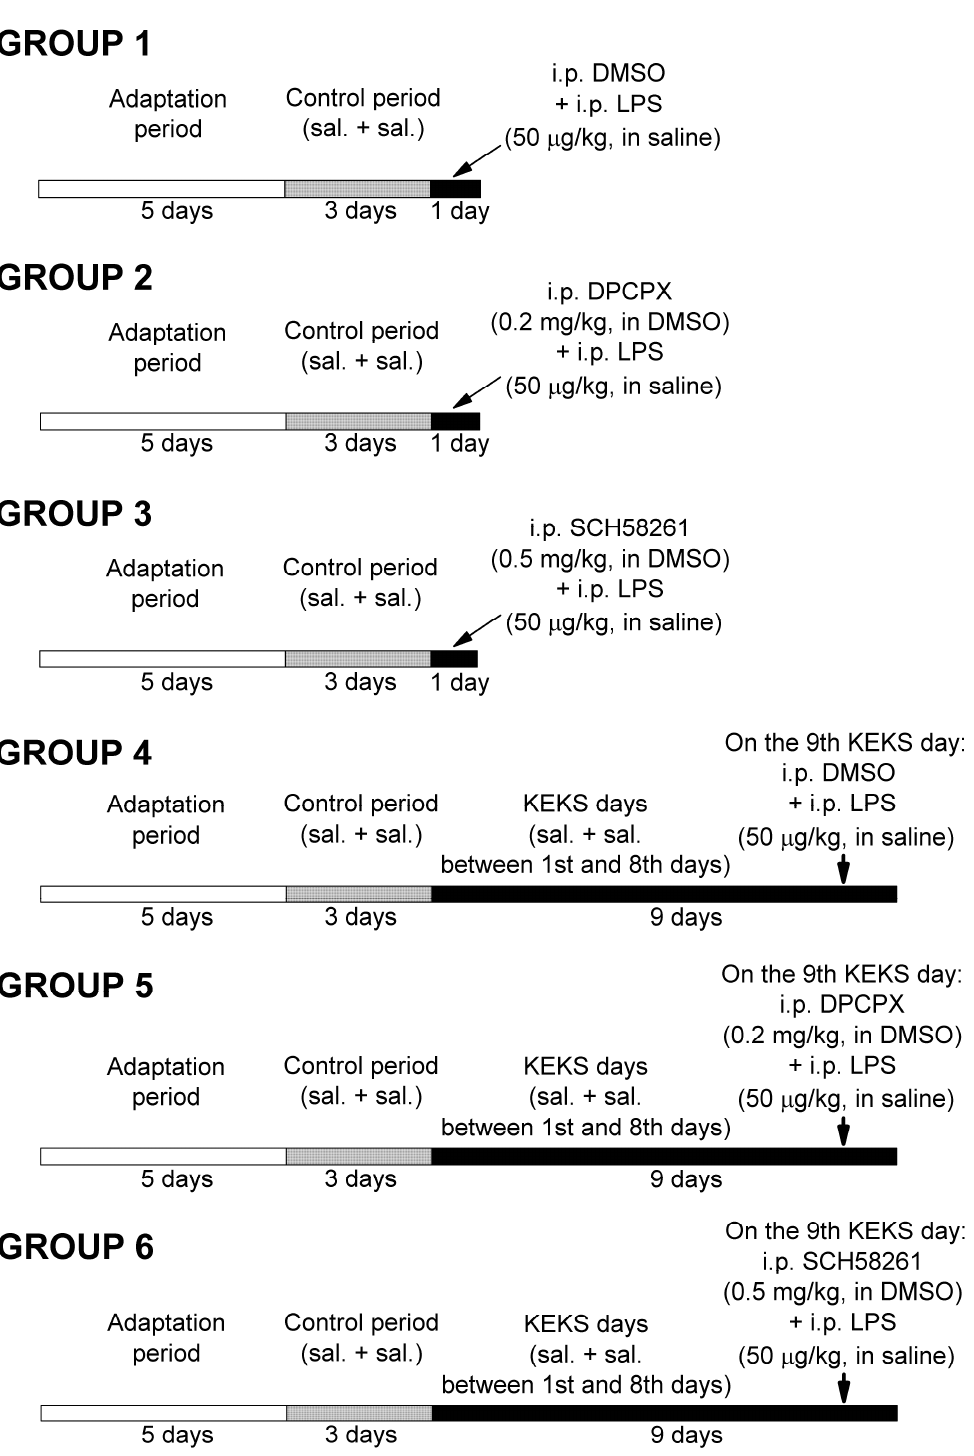
Figure 1. Experimental design. Abbreviations: DMSO, dimethyl sulfoxide; DPCPX, 1,3-dipropyl-8-cyclopentylxanthine; i.p., intraperitoneal; KEKS days, days KEKS food (10% ketone ester/KE, 10% ketone salt/KS and 1% saccharin in paste-like standard rodent chow) administration; LPS, lipopolysaccharide; sal. + sal.: i.p. 0.3 mL saline/100 g body weight (first injection) + 0.3 mL saline/100 g body weight (second injection; 30 min later); SCH582361, 7-(2-phenylethyl)-5-amino-2-(2-furyl)-pyrazolo-[4,3-e]-1,2,4-triazolo[1,5-c]pyrimidine. After three-day control periods, animals in groups 1–3 received two i.p. injections (first injections were followed by second injections 30 min later) on the fourth day